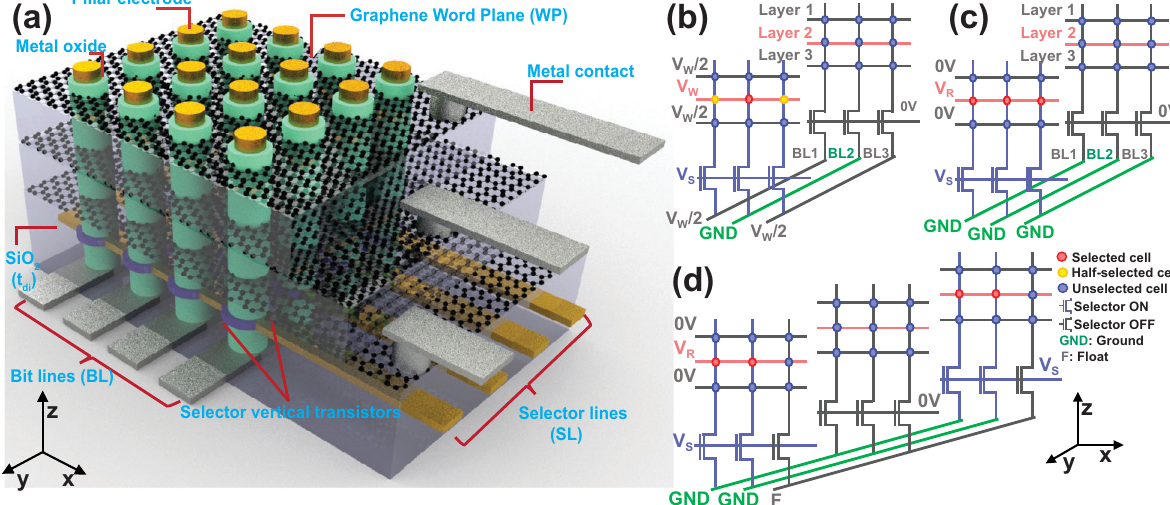
Fig. 4 3D VRRAM array structure. a A schematic of a virtual 3D VRRAM array with atomically thin graphene WP. b, c Array biasing scheme for write and read operations, respectively. d Planar array-based WS operation scheme, where BLs are utilized as the neuron The modeling of the 3D VRRAM array with graphene word planes Figure 4a illustrates a virtual 3D VRRAM array schematic with a 2D graphene fi lm as the WP electrode. The thickness t di of the isolation layer (SiO 2 dielectric) is selected according to the type and dimensions of the plane electrode. The vertical density of the 3D array highly depends on the isolation layer and word plane thicknesses; thus, Gr-RRAM brings favorable impact. More detailed